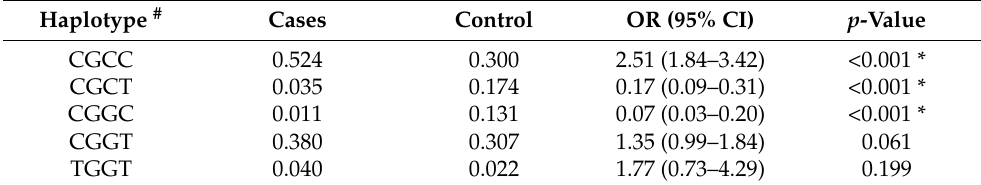
Table 7. Haplotype analysis of the β -like globin